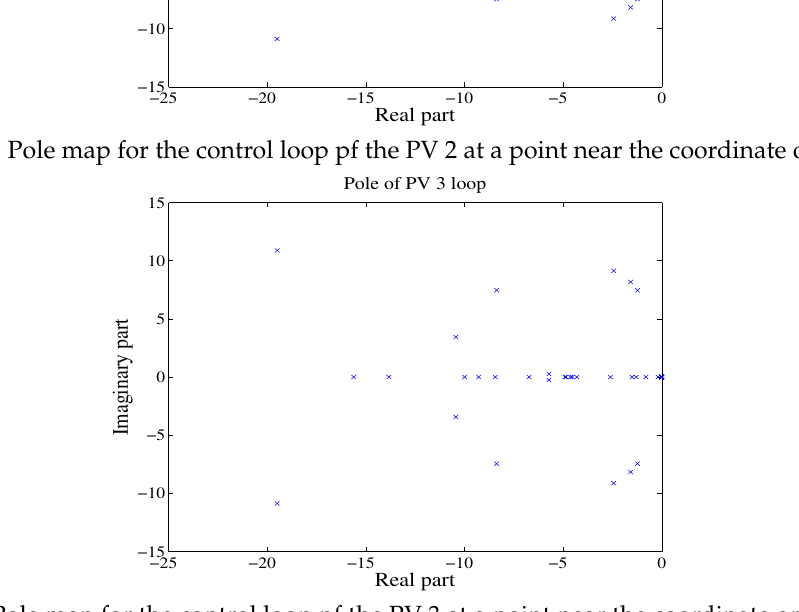
Figure 27. Pole map for the control loop of each